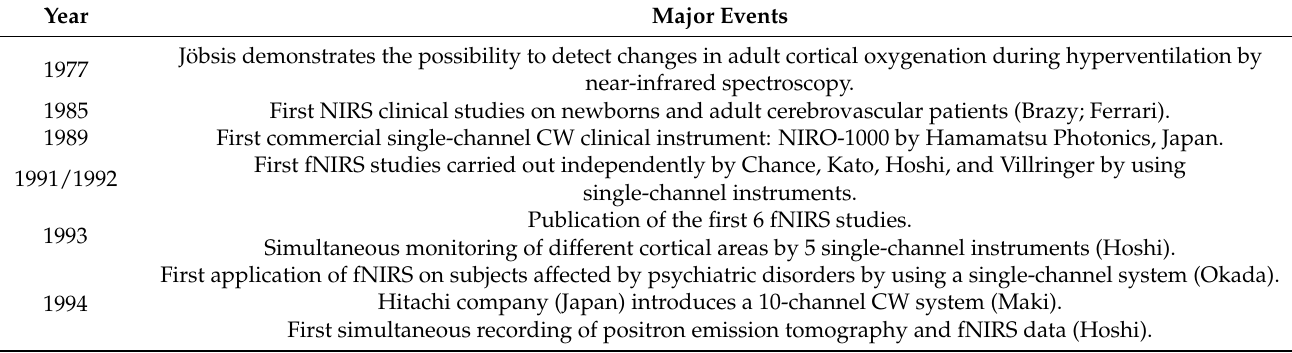
Table 1. A timeline overview of the development of fNIRS and fields of application. (Reprinted from